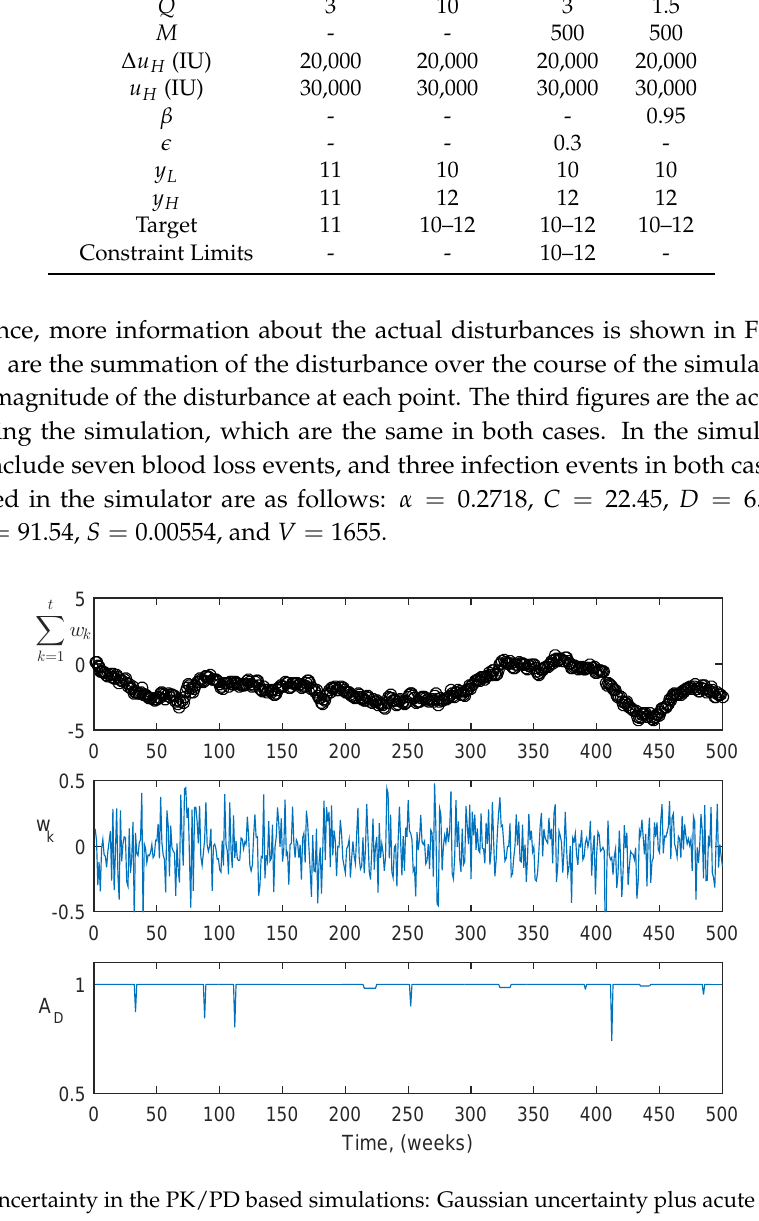
Figure 9. Uncertainty in the PK/PD based simulations: Gaussian uncertainty plus acute